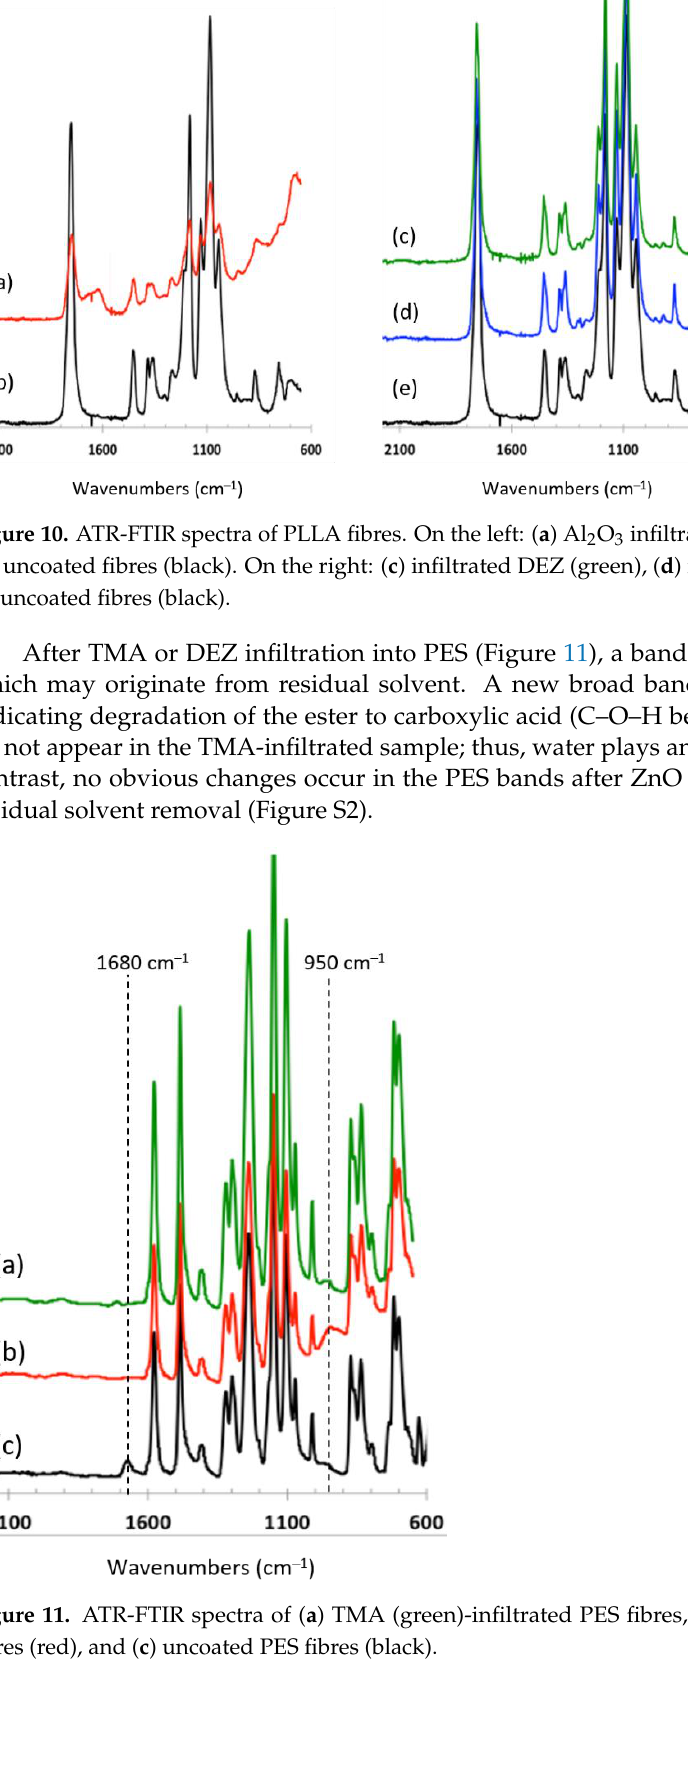
Figure 10. ATR-FTIR spectra of PLLA fibres. On the left: ( a ) Al 2 O 3 infiltrated PLLA fibres (red) and ( b ) uncoated fibres (black). On the right: ( c ) infiltrated DEZ (green), ( d ) infiltrated ZnO (blue) and e) uncoated fibres (black).